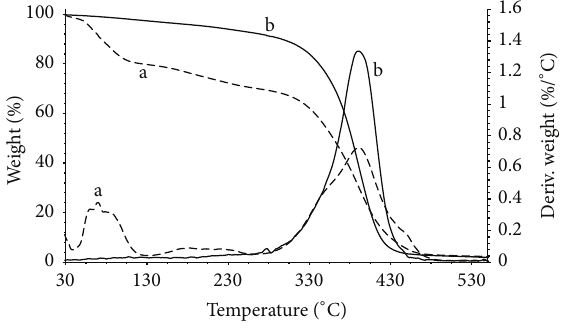
Figure 5: TGA thermograms and corresponding derivative curves of the (a) P-EMACO and (b) X-EMACO-Styrene copolymer. Table 1: The comparative storage modulus values of different oil based polymer